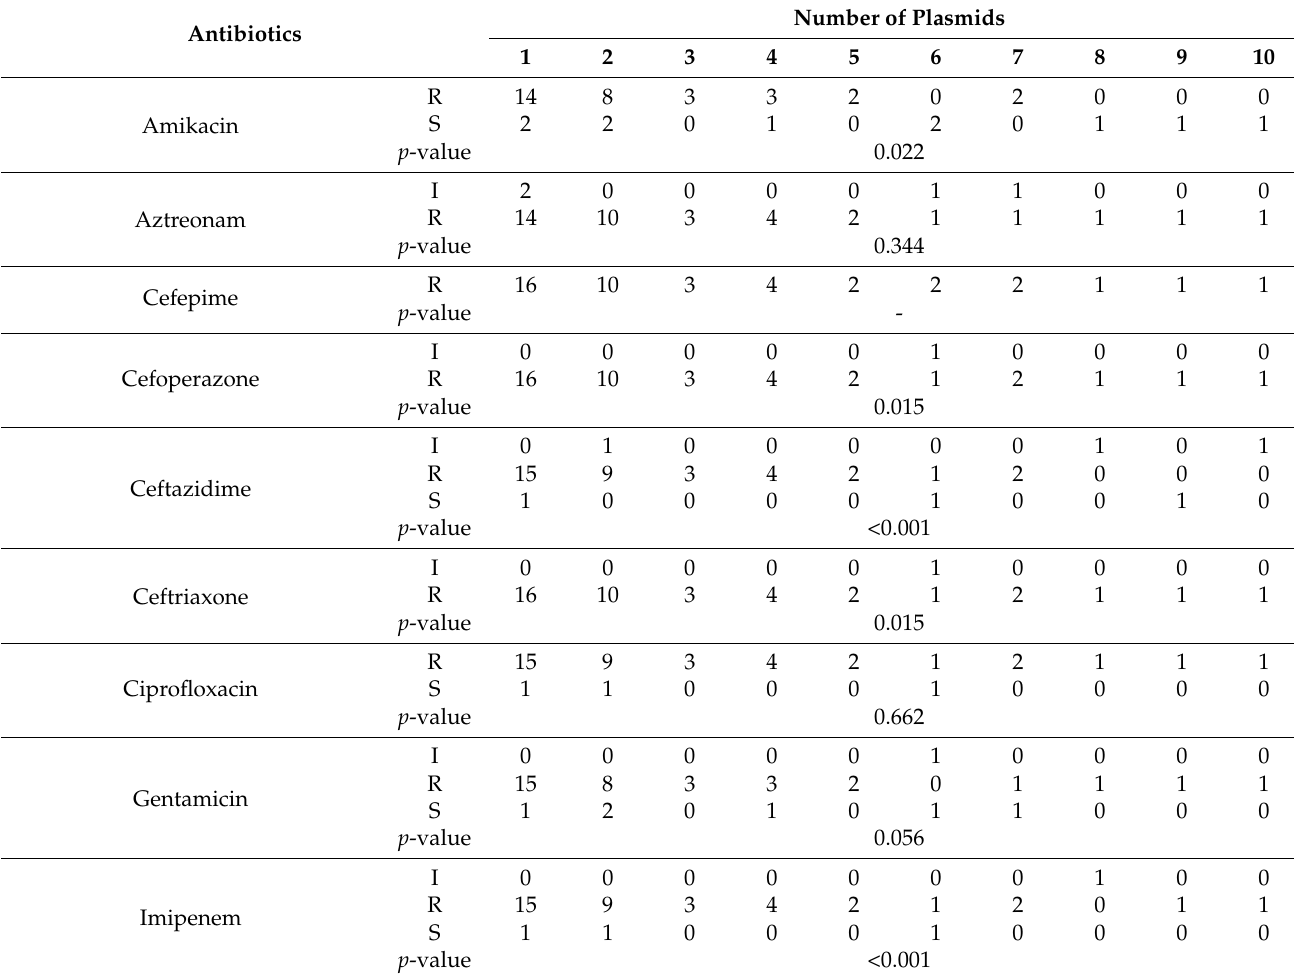
Table 5. Number of plasmids identified in correlation to antibiotic sensitivity testing and presence of OXA enzymes in the Acinetobacter baumannii